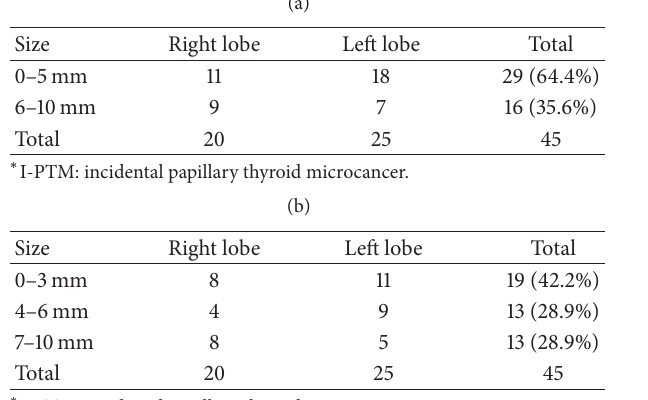
Table 5: (a) Size distribution of 45 I-PTM ∗ foci. (b) Size distribution of 45 I-PTM ∗